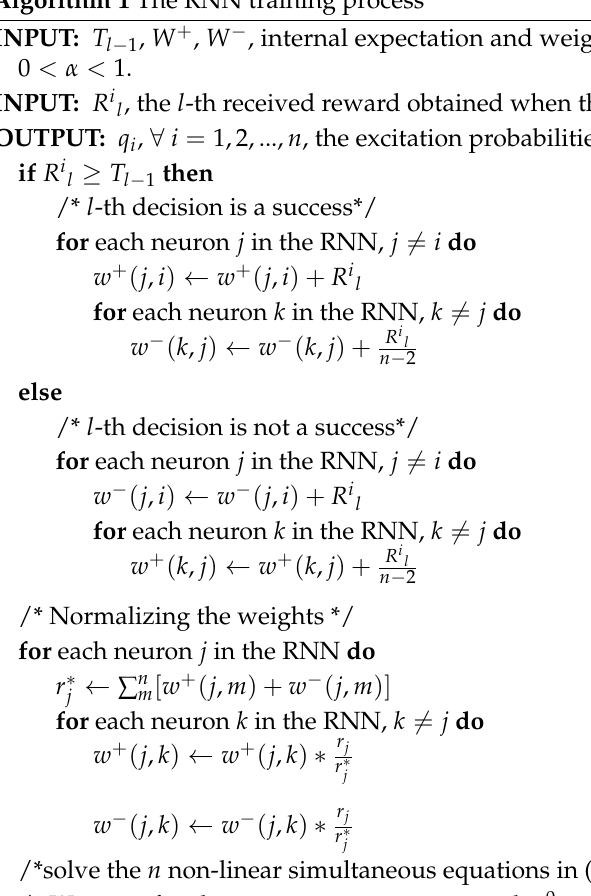
Algorithm 1 The RNN training